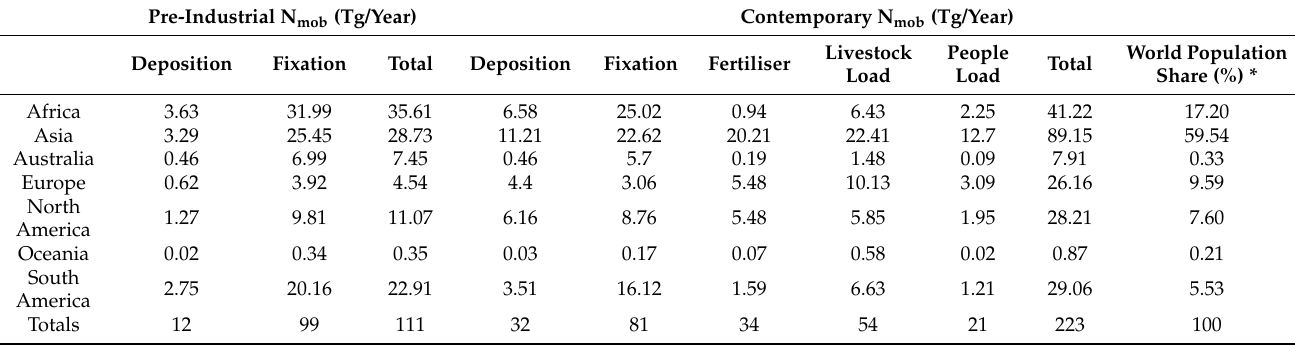
Table 1. Pre-industrial and contemporary mobilisable nitrogen loadings